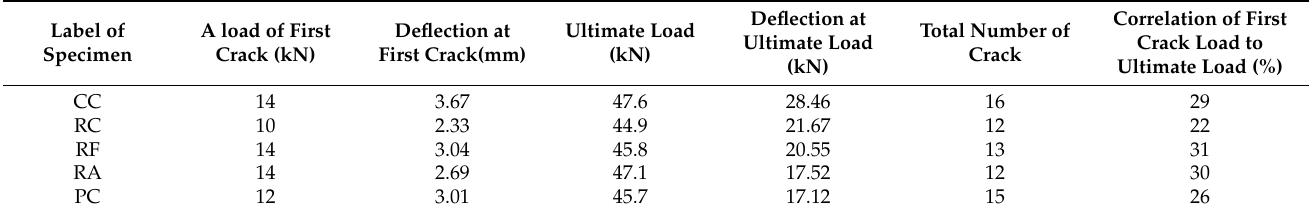
Table 4. Load related to the first crack and number of cracks.